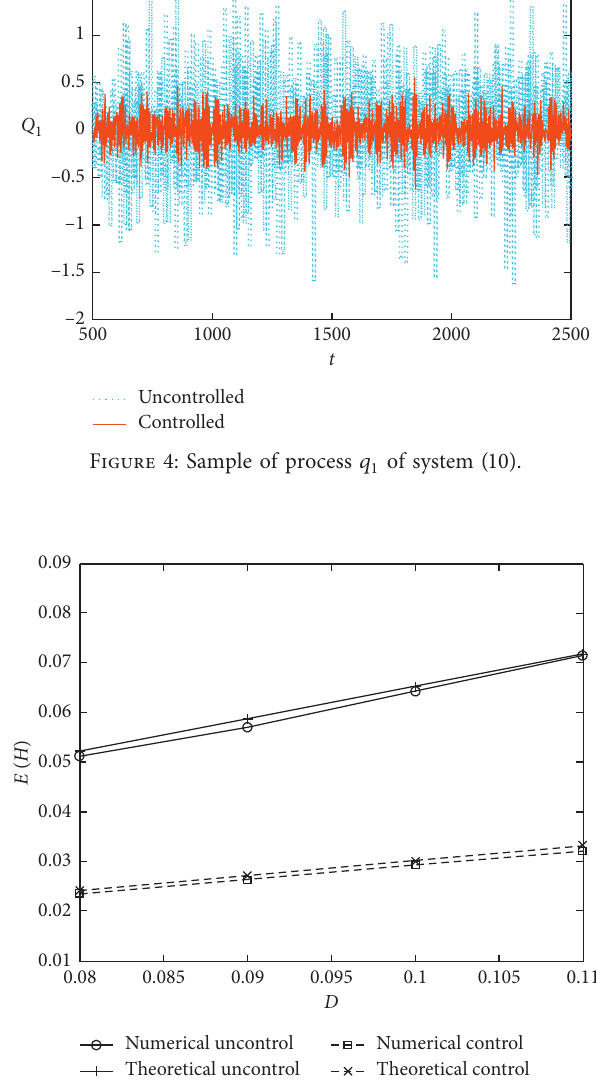
Figure 5: Mean value E [ H ] of system (10) as function of D .